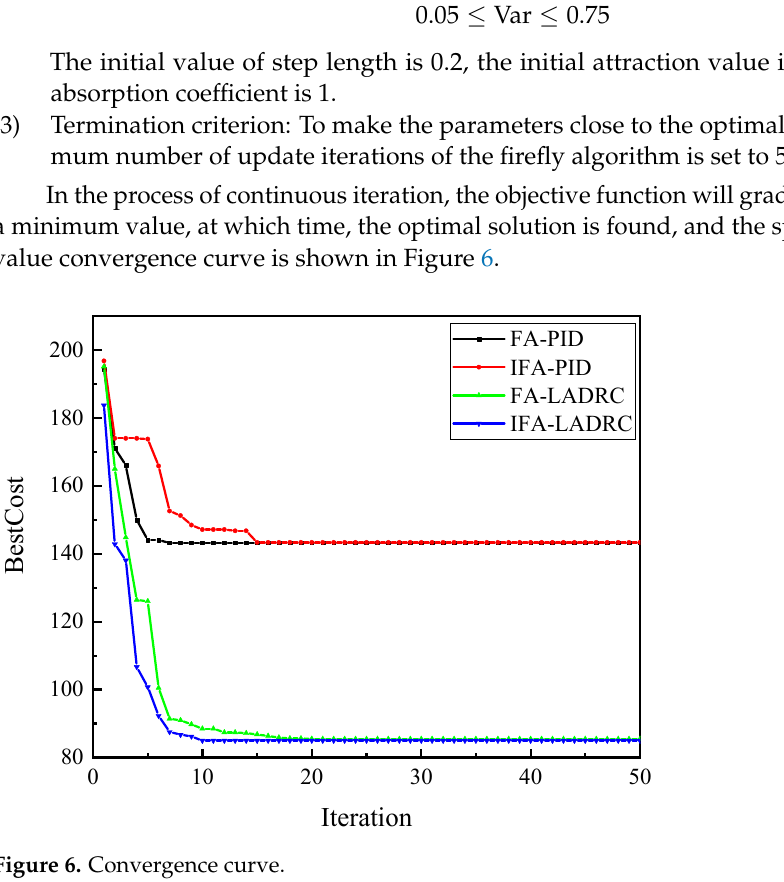
Table 4. Optimization parameters under LADRC and error integration index.